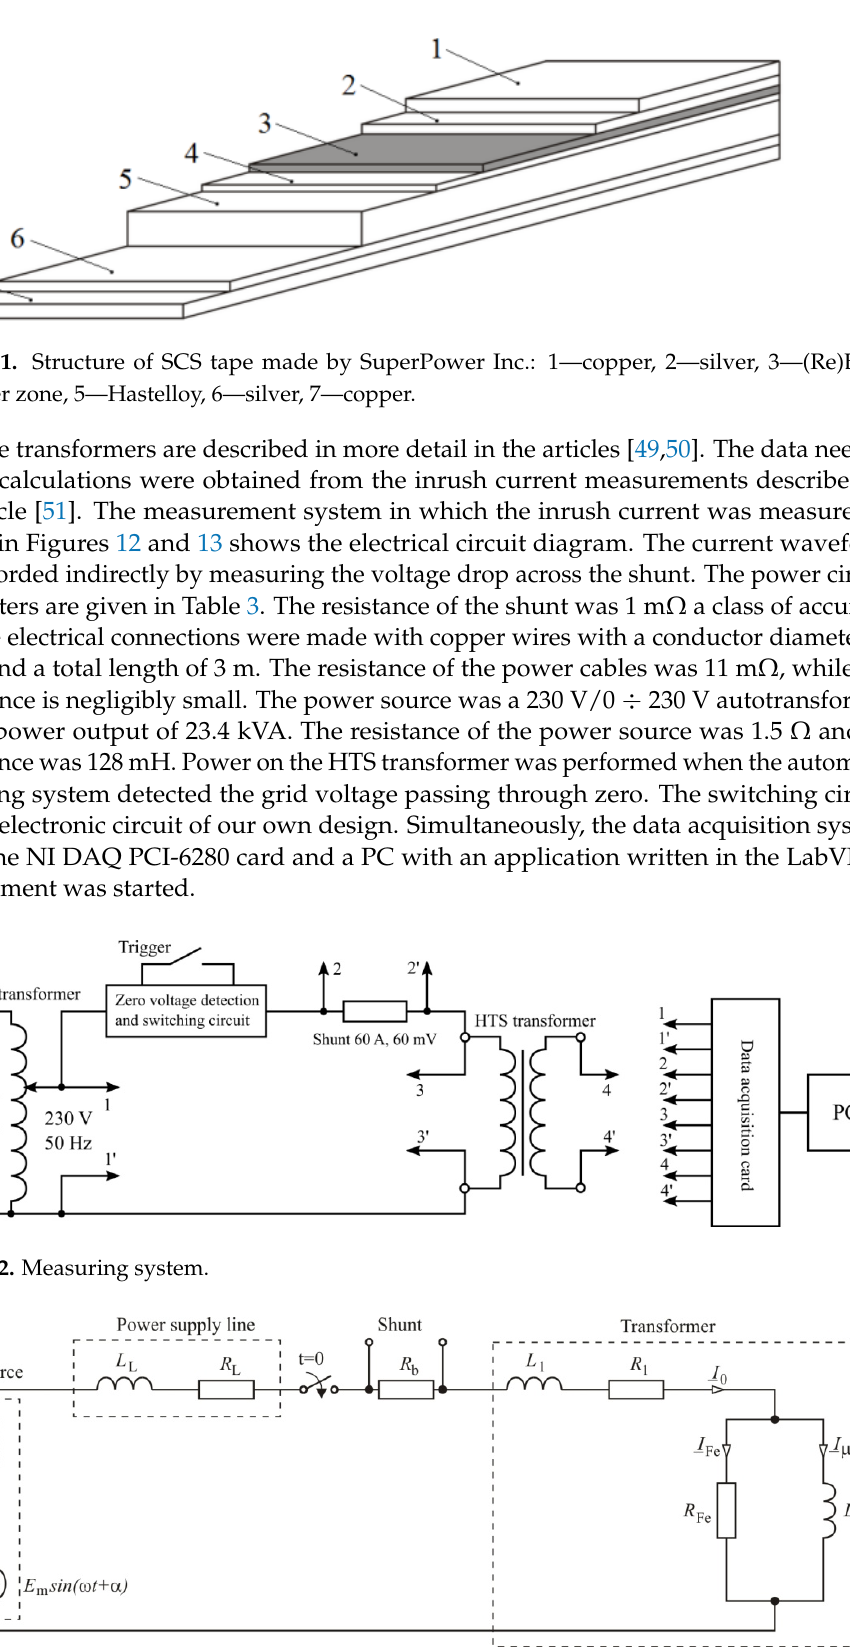
12 of 19 Figure 10. Construction of a 13.8 kVA superconducting transformer, 1—cryostat, 2—primary winding carcass, 3—primary winding HV, 4—current bushings, 5—secondary winding carcass, 6—secondary winding LV, 7—channels cooling. The superconducting windings were wound on glass composite carcasses and placed in cryostats made of the same material. The cooling liquid was nitrogen. All electrical connections inside the cryostat were made with superconducting wires by tin soldering. The primary winding of the 8.5 kVA transformer uses the SCS4050 superconducting tape (SuperPower Inc., Glenville, WV, USA) with a minimum critical current of 115 A, at 77 K and in its own field. For the primary winding of the 13.8 kVA transformer, the SCS4050-AP type tape with a minimum critical current of 87 A. The secondary winding of the 8.5 kVA transformer is made of SCS4050 tape and the 13.8 kVA transformer is made of SCS12050-AP tape with a minimum critical current of 333 A, at 77 K and in its